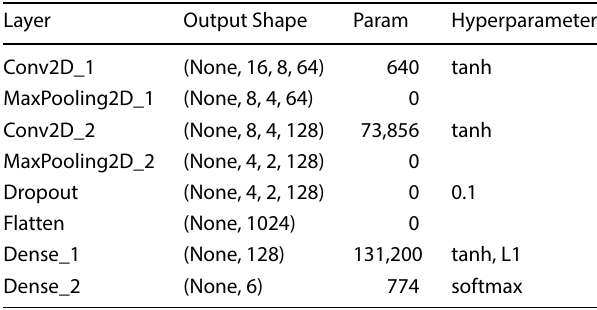
Table 1 Parameters of the